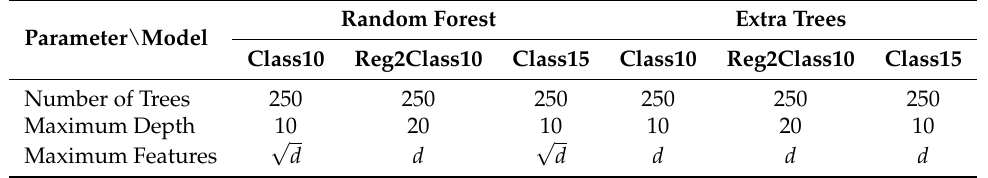
Table 5. Hyperparameters for each of the best performing Random Forest and Extra Trees models on each task. Random Forest Extra Trees Parameter \ Model Class10 Reg2Class10